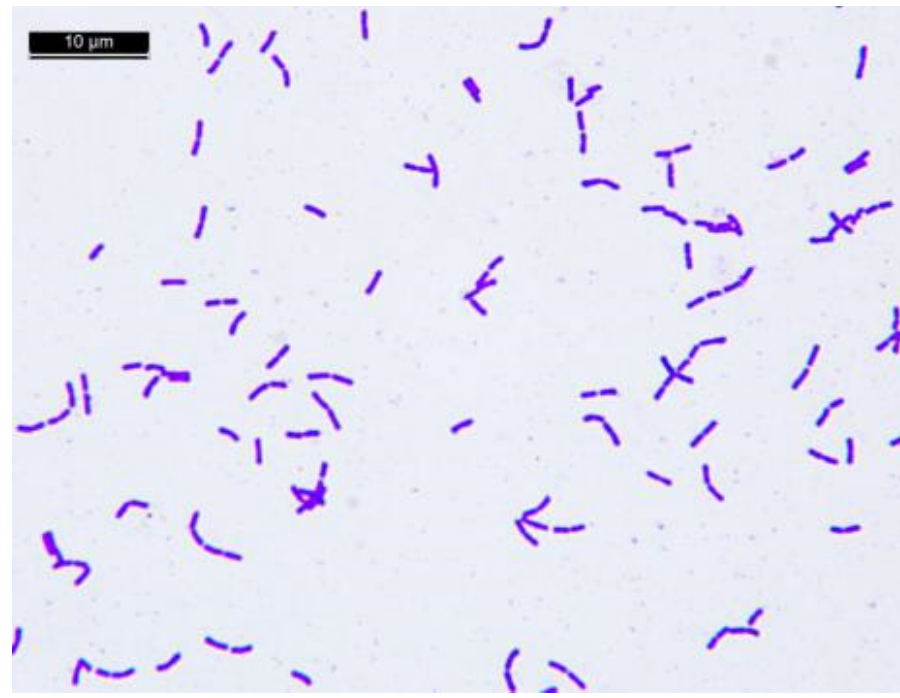
Figure 1. Gram stain cell morphology of Lacticaseibacillus casei Zhang (scale = 10 μ